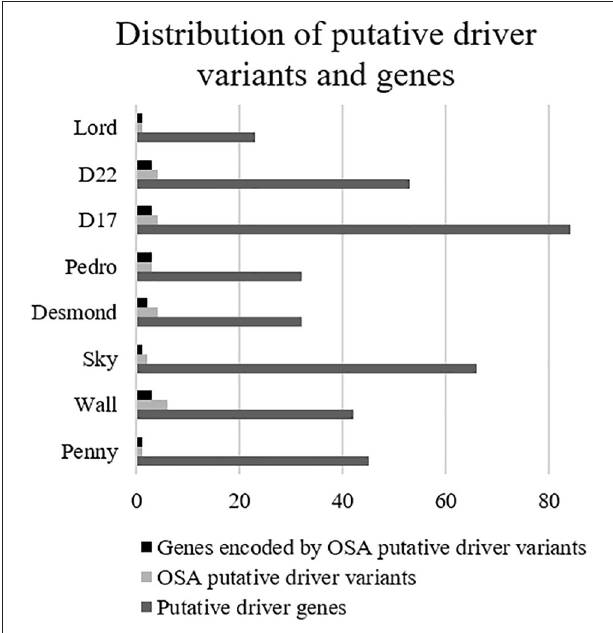
FIGURE 6 | Distribution of putative driver variants and encoded genes across canine osteosarcoma cell lines.